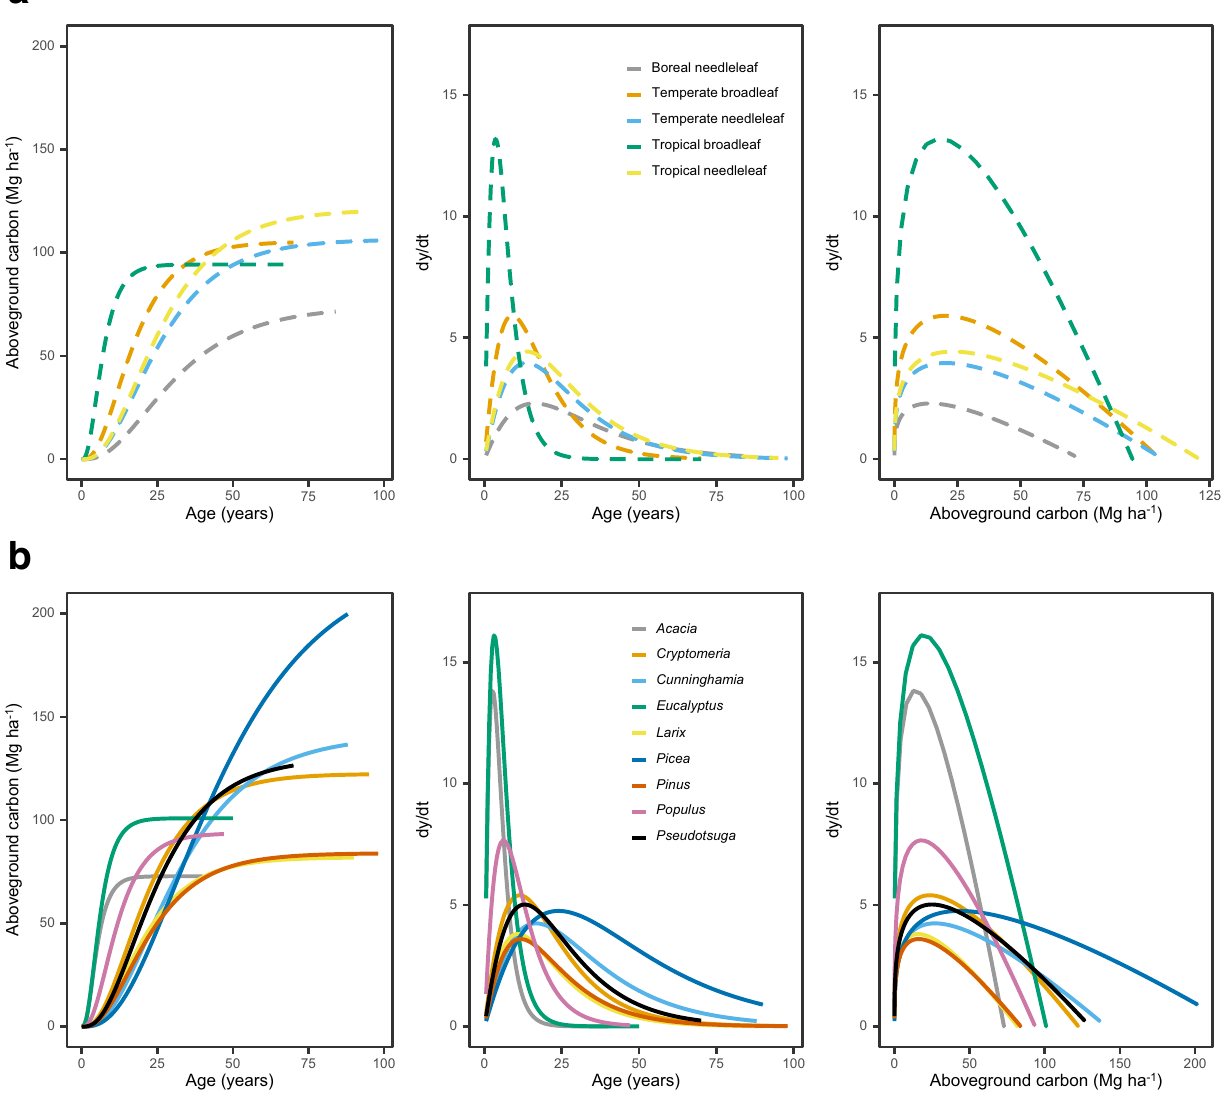
Fig. 5 Comparison of aboveground carbon accumulation and growth rates across plantation types. Aboveground carbon accumulation as a function of age, growth rate as a function of age, and growth rate as a function of stand level aboveground carbon are shown for different plant functional types ( a ) and genera ( b ). The growth rate (dy/dt) is calculated using the differential form of the Chapman-Richards function. All model parameters were estimated with the m parameter of the Chapman-Richards growth function fi xed at 0.67 (i.e., von Bertalanffy special case of the Chapman-Richards growth